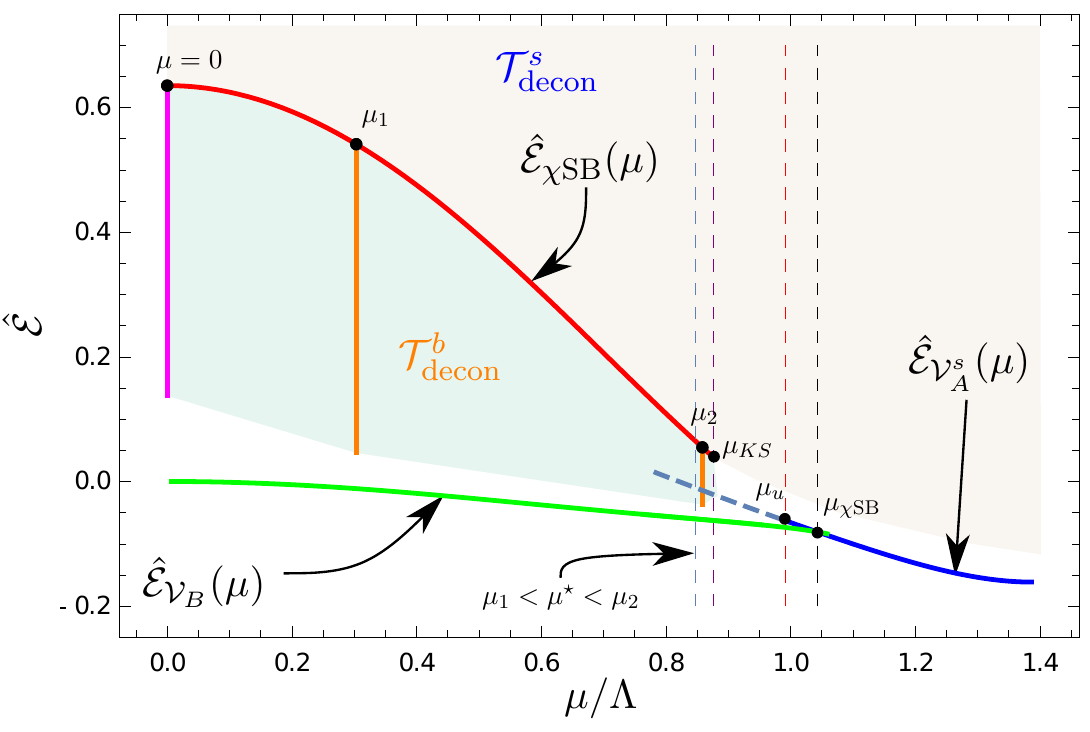
s states, (the shaded region decon T b states, (the shaded region labeled decon T